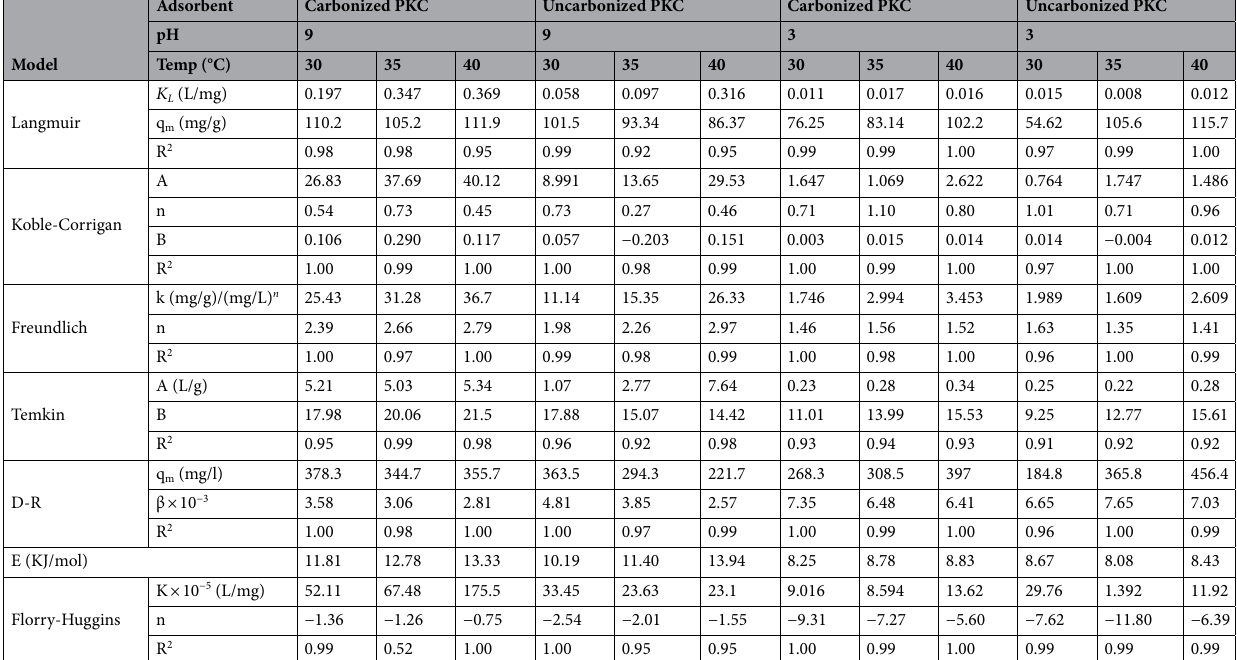
Table 1. Sorption isotherm parameters for non-linear